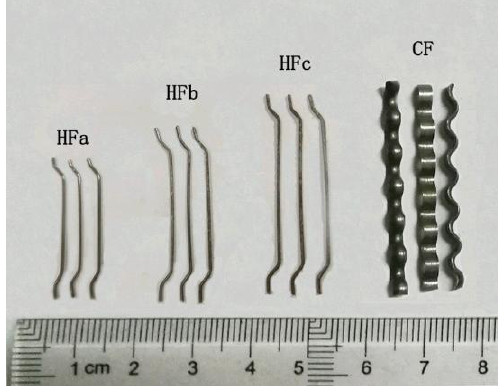
Table 1. Physical and mechanical properties of steel fibers. HF, hooked-end steel fiber; CF, crimped steel